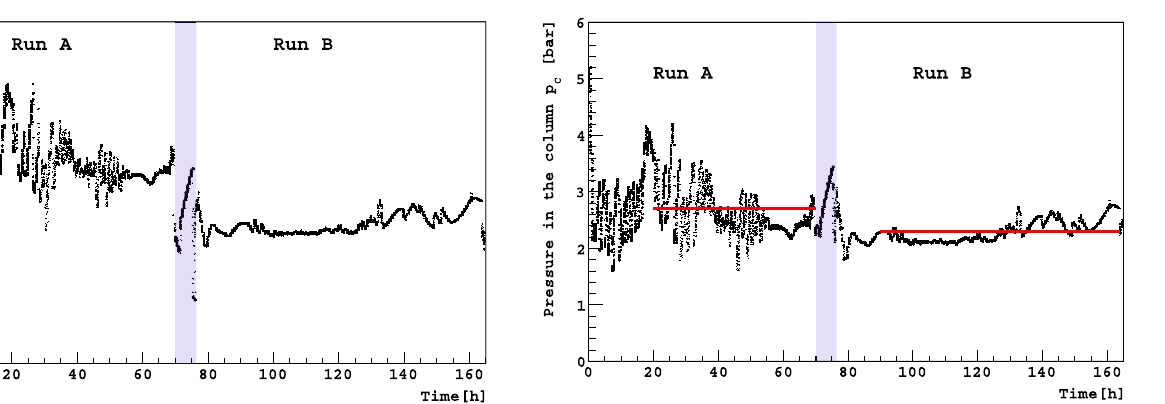
Fig. 14 Measured pressure inside the column, p C , in the top vs time, for 29 N 2 – 28 N 2 distillation in the prototype plant. The red horizontal lines indicate the average pressure values in Run A and Run B of 2 . 7bar and 2 . 3bar, respectively. The averages are taken only for time periods after the distillation transients of both runs are over, as observed in Fig. 16